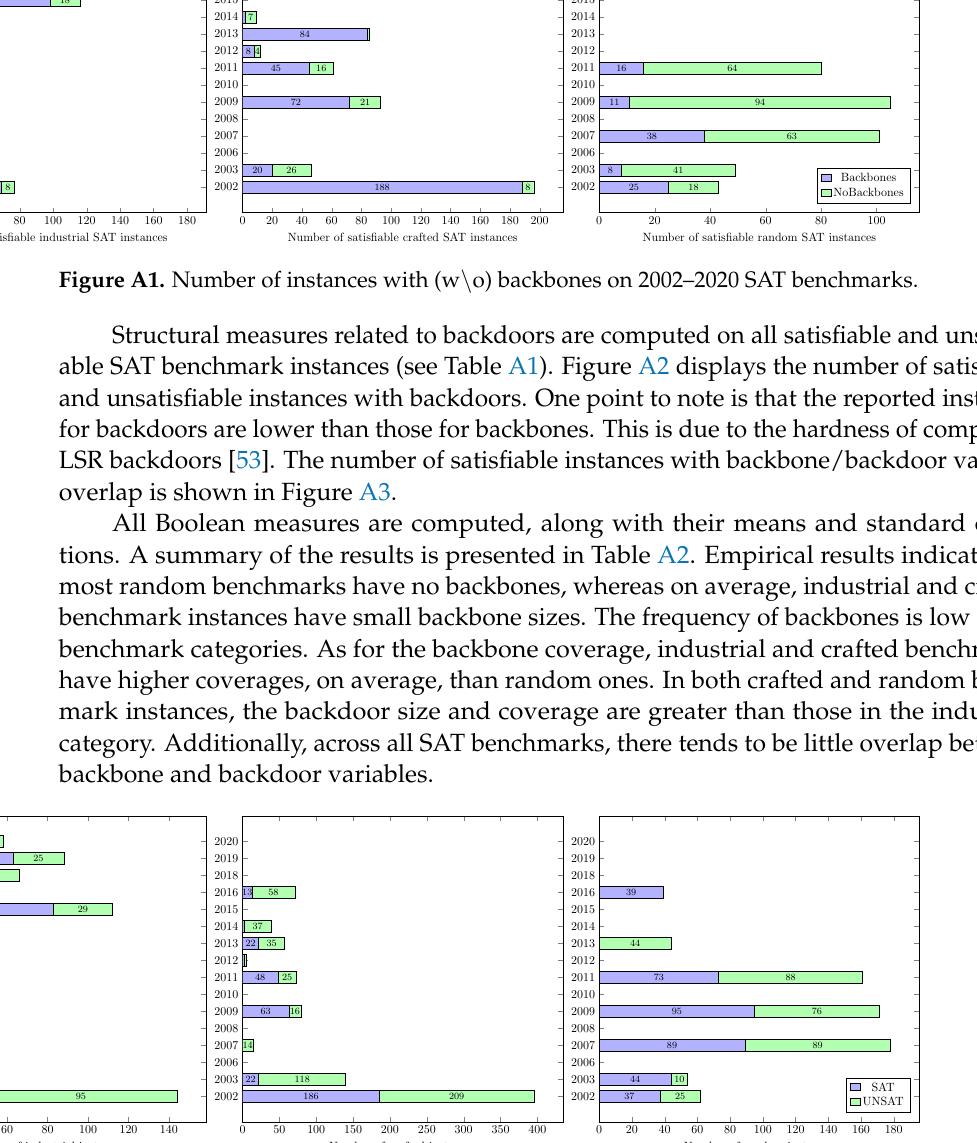
Figure A2. Number of satisfiable/unsatisfiable instances with backdoors on 2002–2020 SAT bench- mark